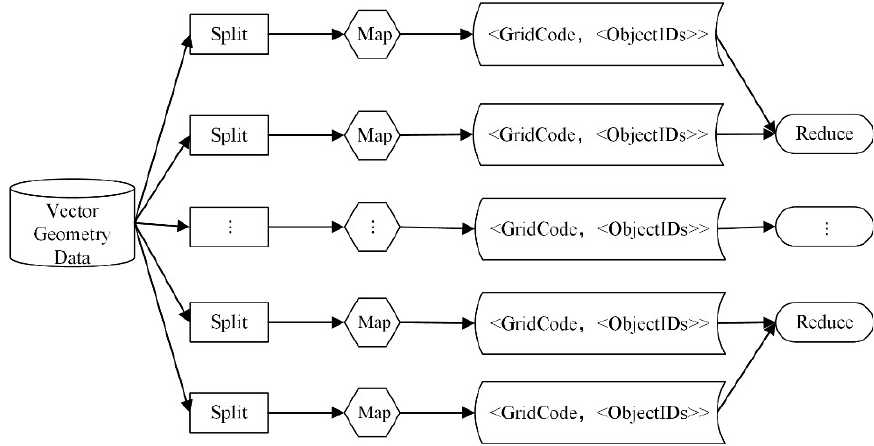
Figure 10. Flowchart of the index parallel construction based on MapReduce.